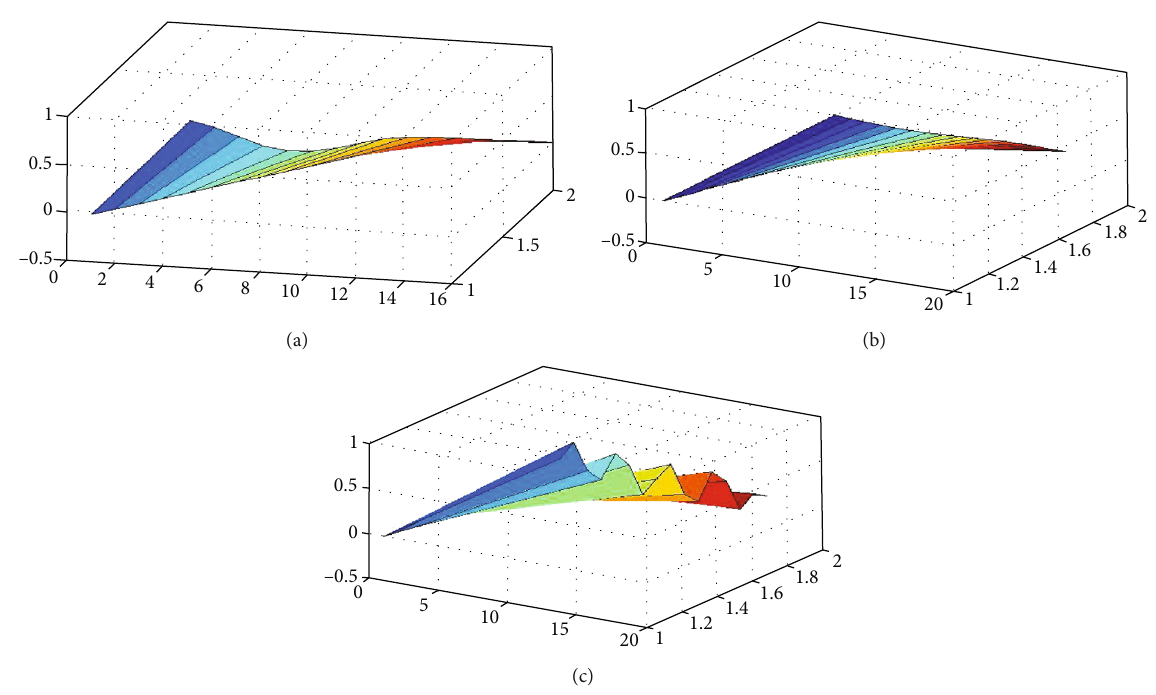
Figure 12: (a – c) Mode shapes of cross-ply annular circular plate ( V